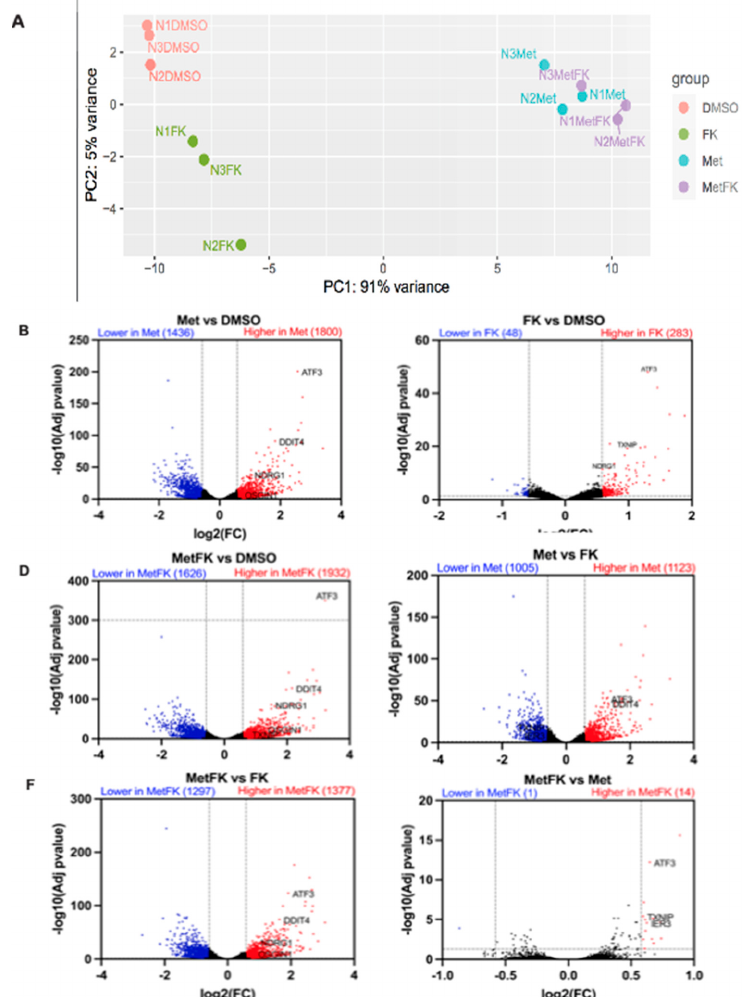
Figure 6. Differential gene expression in KP4 cells treated with metformin, FK866, or both. ( A ) Prin- cipal component analysis (PCA) and ( B – G ) volcano plots of differentially expressed genes (DEGs) from the RNAseq data obtained from KP4 cells treated as indicated for 24 h. ( A – G ) n = 3. In order to understand why FK866 increased metformin sensitivity, we performed GSEA, comparing cells treated with Met+FK to metformin alone, FK866 alone, and vehi- cle. This analysis revealed that the drug combination reactivated the p53 pathway in KP4 cells, as well as the unfolded protein response (UPR), which are both able to trigger cell death. These genes include ATF3 , IER3 , OSGIN1 , NDRG1 , DDIT4 , UPP1, and GADD34 (Figure 7A,B). The p53 target gene ATF3 can activate up to 40% of p53 target genes, sug- gesting a mechanism for p53 pathway reactivation in p53 null cells [38–40]. IER3 plays a role in cell death induced by chemotherapy [41,42]. OSGIN1 is a mediator of apoptosis which is upregulated by oxidative stress and p53 [43]. NDRG1 is a metastasis suppressor induced by p53 and iron chelators [44,45]. TXNIP is a negative regulator of TRX, leading